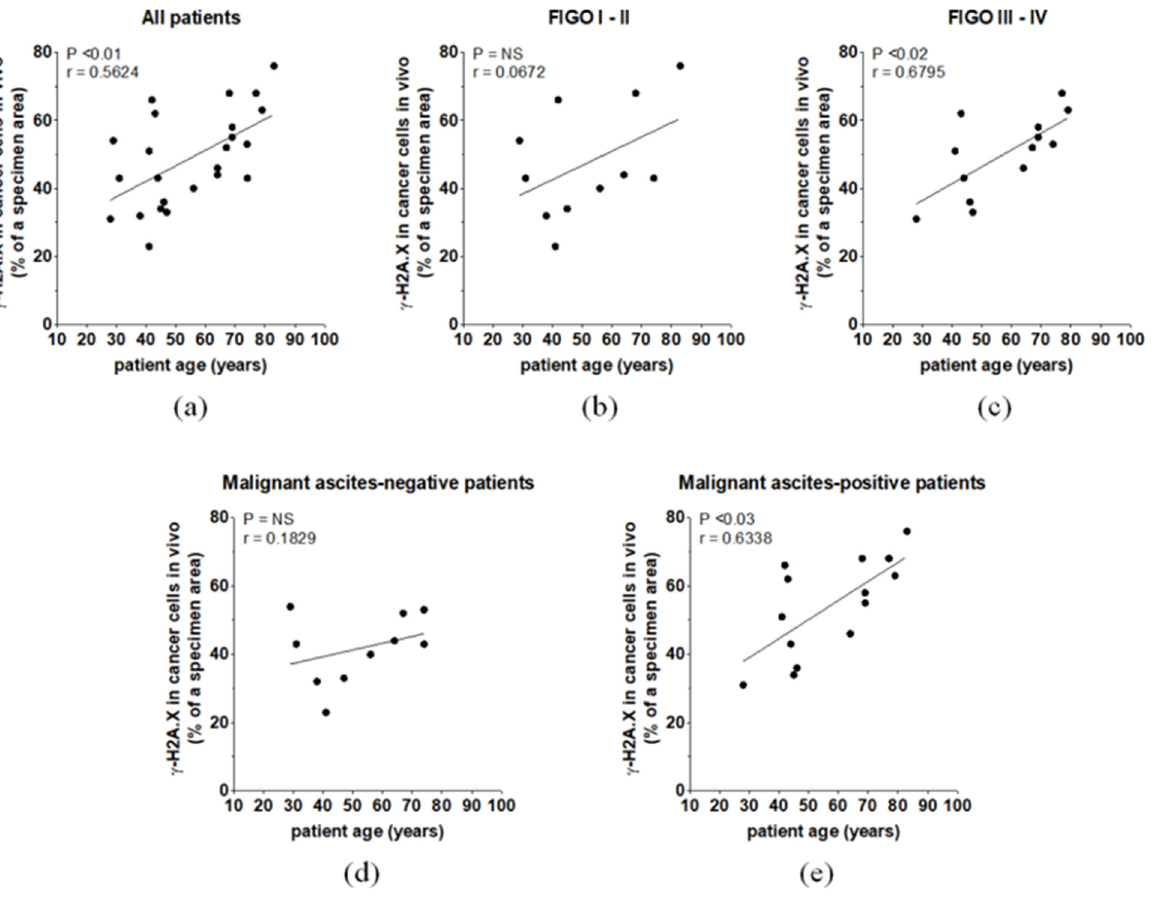
Figure 5. The relationships between ovarian patient age and γ -H2A.X level in the whole cohort ( a ), patients with different FIGO stages ( b , c ), and patients with different malignant ascites statuses ( d , e ).